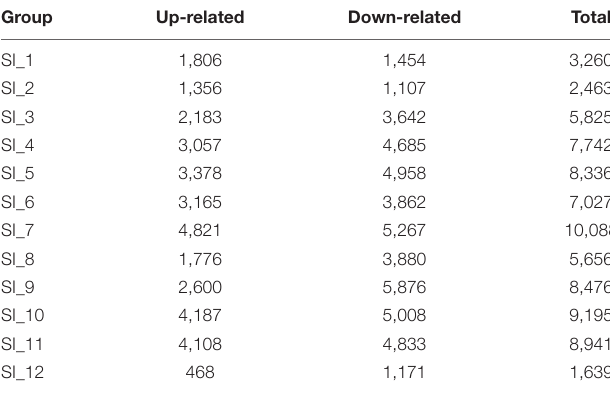
TABLE 1 | Statistics of the number of